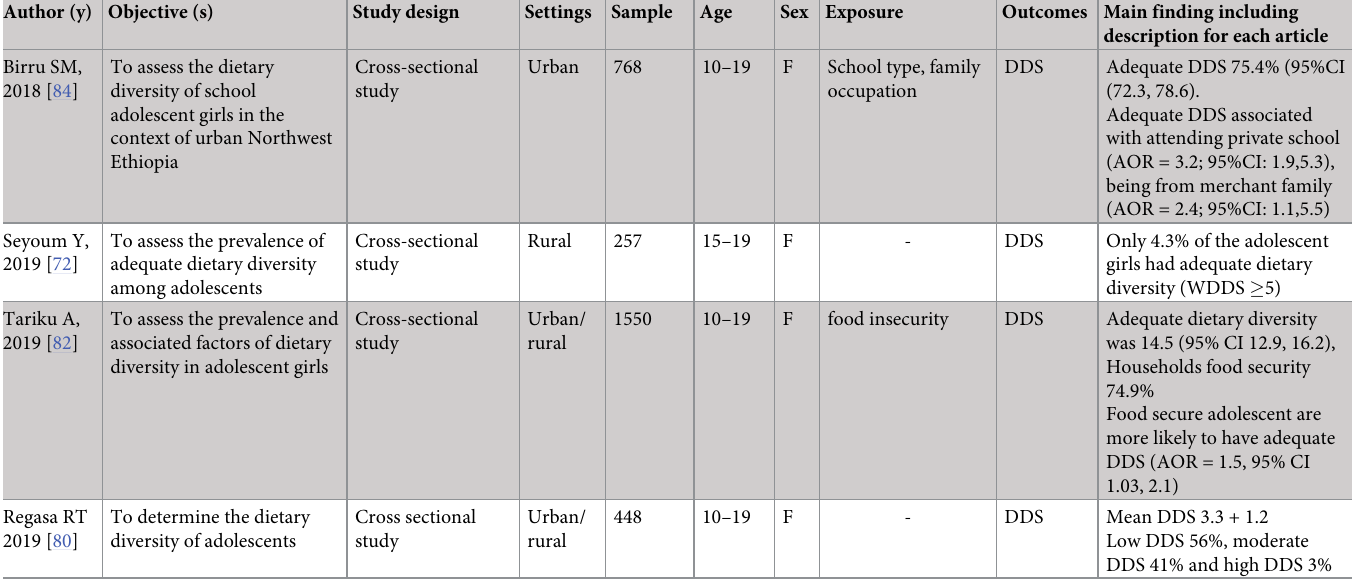
adolescents were food insecure during each consecutive round of the survey respectively [27]. In addition, 5.5% girls and 4.4% boys (P = 0.331) were from food insecure households in all three follow ups [25]. The mean height of food insecure girls was shorter by 0.87 cm (P < 0.001) compared with food secure girls at baseline [25]. Predictors of food insecurity in the longitudinal study include, urban households within low (AOR = 1.7; 95% CI: 1.2, 2.5) and middle (AOR = 1.8; 95% CI: 1.2, 2.6) compared to high income tertiles were nearly twice as likely to suffer from chronic food insecurity [24]. Female sex (AOR = 1.6; 95% CI: 1.2, 2.1), high dependency ratio (AOR = 1.5; 95% CI: 1.0, 2.2) and household food insecurity (AOR = 2.7; 95% CI: 2.0, 3.6) among adolescents in urban, semi-urban, and rural areas were positively associated with food insecurity, while higher educational status was negatively asso- ciated (AOR = 0.5; 95% CI: 0.3, 0.8) [24]. Food insecure adolescents had lower DDS (P = 0.001), low mean food variety score (P = 0.001) and a lower frequency of consuming